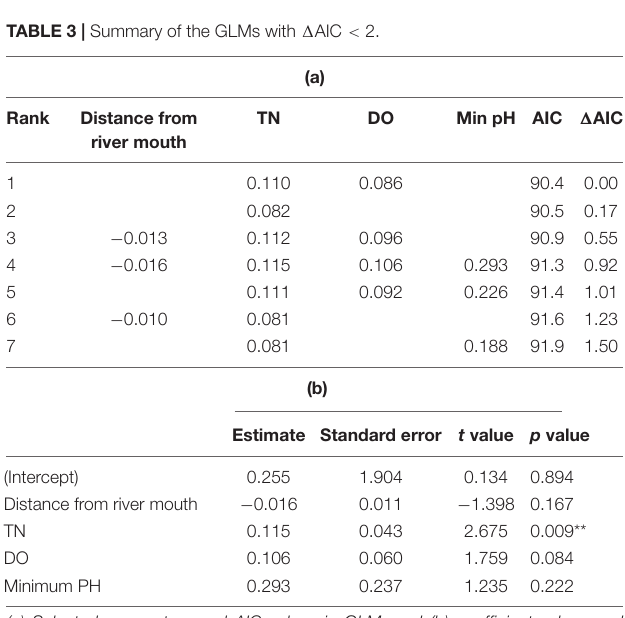
FIGURE 5 | Relationship between the number of particles that reached near the rivers and eDNA detection. The solid line and gray area indicate the best regression curve and the 95% confidence interval, respectively.